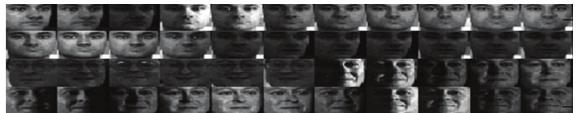
Figure 10: Cropped example face images from the Extended Yale Face Database B database under different illuminations.